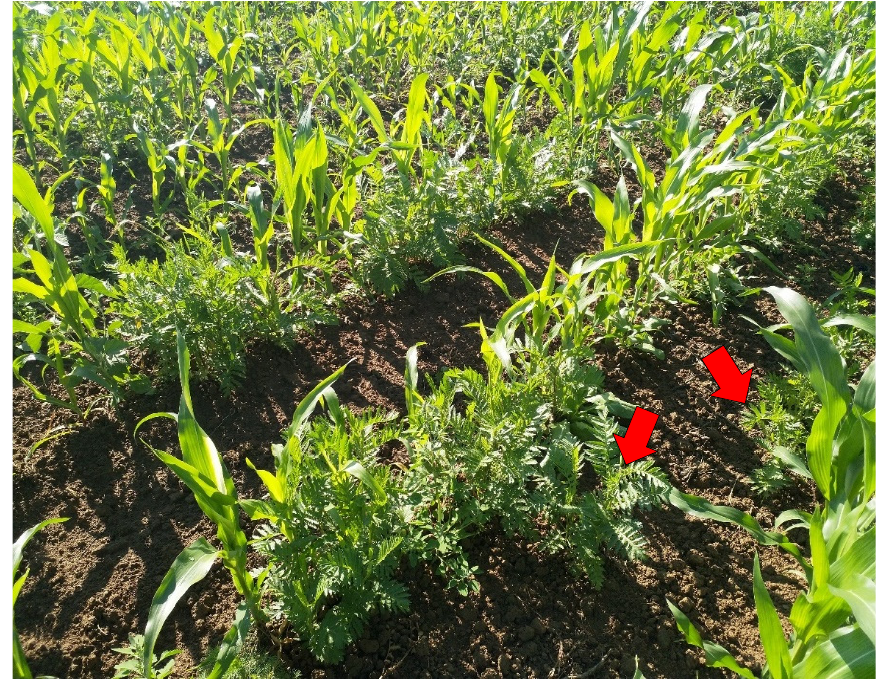
Figure 4. An impression of the maize plant stand within the treatment area “after wild plant cultivation”, two days after the mechanical weeding was carried out (21 June 2021). While most of the common tansy plants and the other non-target species between the maize rows were destroyed, a few common tansy individuals survived (red arrows).